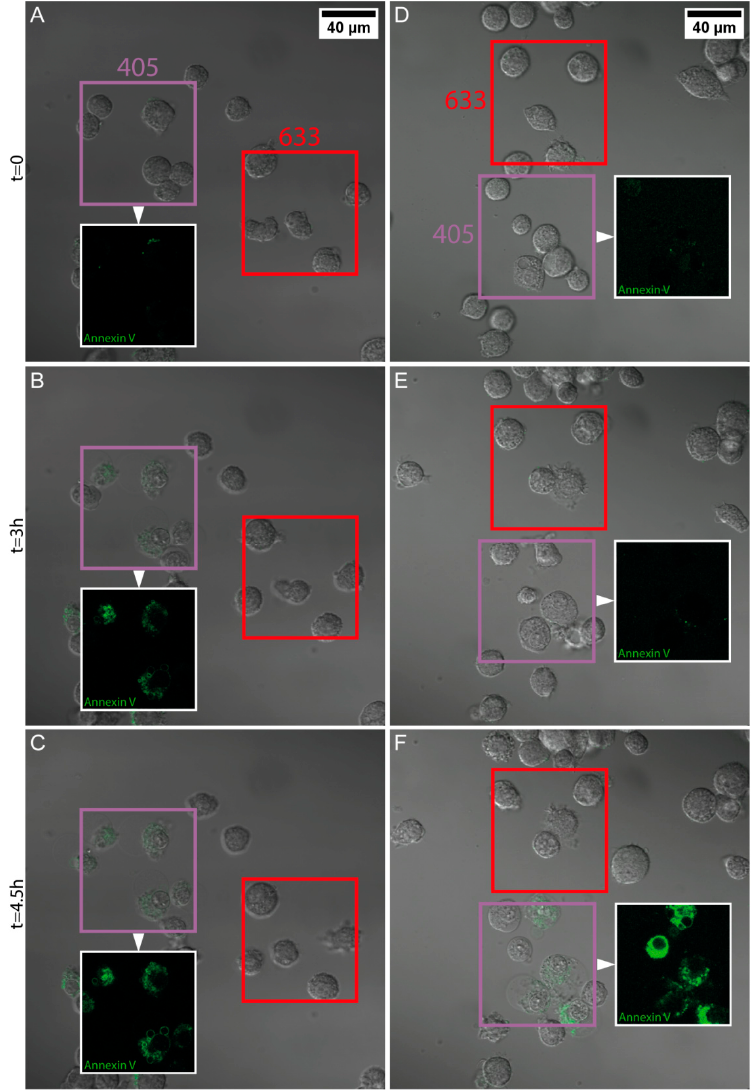
Figure 3. Rate of apoptosis induction in the J774A.1 mouse macrophages exposed to the PDA/HSA NPs, upon light irradiation. The macrophages were exposed to 20 μ g/mL PDA/HSA NPs ( A – C and Supplementary Video 2) or media only ( D – F and Supplementary Video 3). Subsequently, two